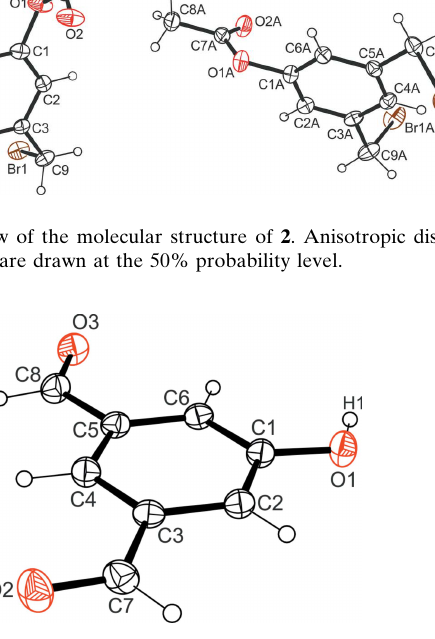
Figure 3 Perspective view of the molecular structure of 3 . Anisotropic displace- ment ellipsoids are drawn at the 50% probability level.